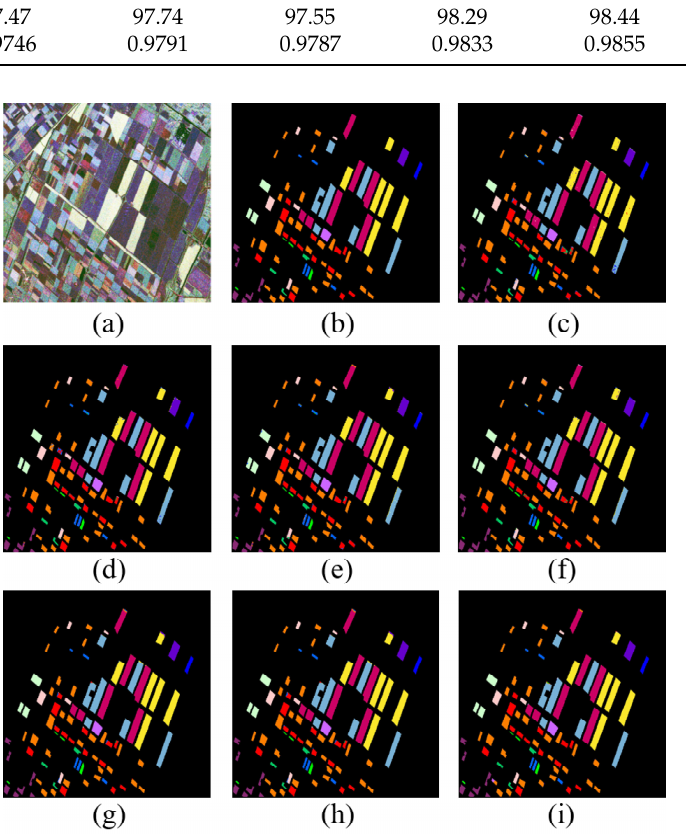
Figure 9. Result of the Flevoland-14 dataset: ( a ) pseudocolor image; ( b ) ground truth; ( c )